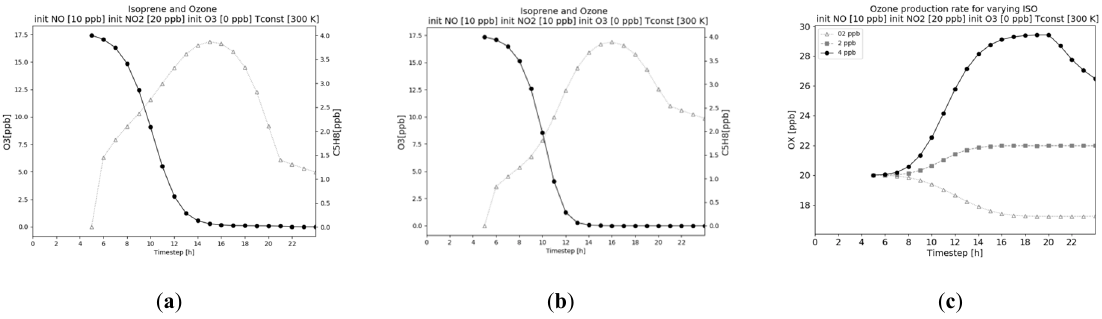
Figure 8. Diurnal variation of ozone (grey) and isoprene (black) for ( a ) NO 2 /NO ratio of 2:1 and ( b ) ratio of 1:1, and ( c ) amount of photochemical oxidants O X (O 2 +NO 2 ). ( b ) ratio of 1:1, and ( c ) amount of photochemical oxidants O